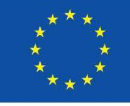
Figure S1: Dependence of CKC adsorption at pure air / water interface on the bulk concentration of CKC; Figure S2: Output of the Fourier transformation of the relaxation transient of pure MGS; Figure S3: Output of the Fourier transformation of the relaxation transient of the MGS layer over the subphase containing CKC; Figure S4: Output of the Fourier transformation of the relaxation transient of the MGS layer in presence of P188; Figure S5: POPC monolayer labeled with DOPE-Atto633 over the subphase containing CKC. Representative epifluorescence images recorded during the compression of monolayer at di ff erent surface pressure / APPL; Figure S6: POPC monolayer labeled with DOPE-Atto633 influenced by P188 present in the subphase. Representative epifluorescence images recorded during one compression experiment in di ff erent film regions at the surface pressure ≈ 25 mN / m; Figure S7: Epifluorescence images of POPC + TO film over the PBS subphase containing CKC; Figure S8: Epifluorescence images of POPC + TO film over PBS subphase containing P188; Figure S9: Epifluorescence images of POPC + TO film over PBS subphase containing CKC + P188; Figure S10: Density profiles of the selected TFLL model components calculated in simulated films with di ff erent area per polar lipid; Figure S11: Density profiles of selected components of the TFLL model calculated in simulated films with di ff erent area per polar lipid in the presence of CKC; Figure S12: Density profiles of selected components of the TFLL model calculated in simulated films with di ff erent area per polar lipid in the presence of P188; Figure S13: Schematic representation of the employed Maxwell models; MD simulation details; Table S1: Compositions of simulated systems; Force field parameters of the ceramide and CKC